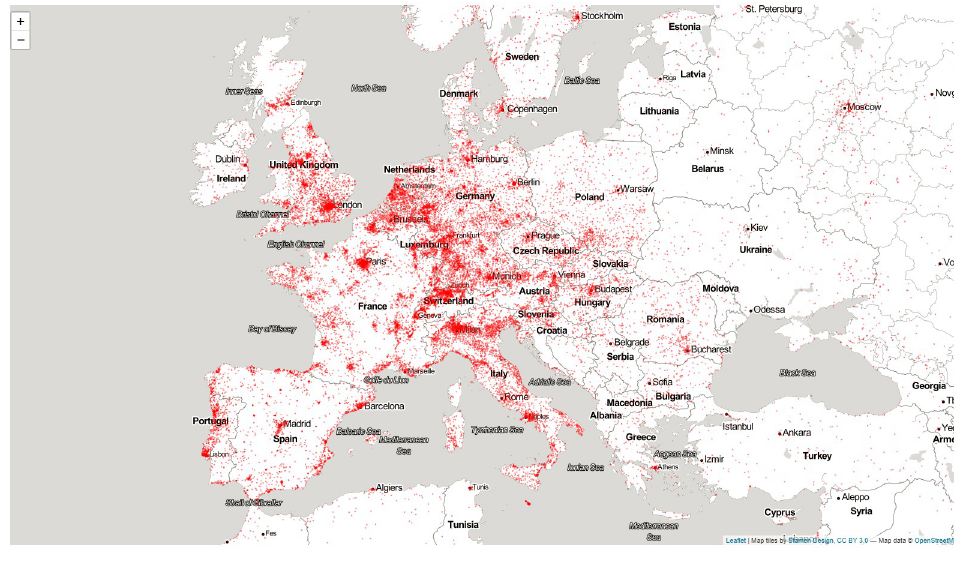
Fig 4. European download